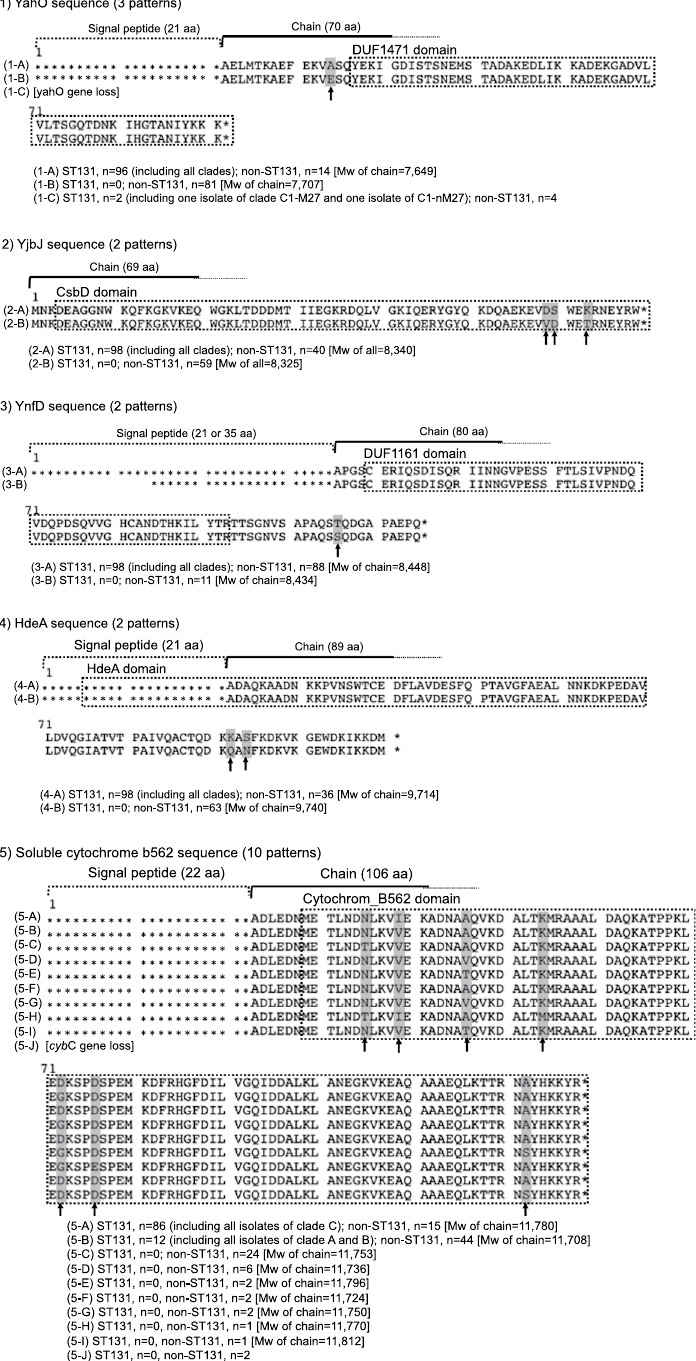
Figure 1. The amino acid sequence and its substitutions specific for ST131. The amino acid sequences of 1) uncharacterized protein YahO, 2) UPF0337 protein YjbJ, 3) uncharacterized protein YnfD, 4) acid stress chaperone HdeA and 5) soluble cytochrome b562 are